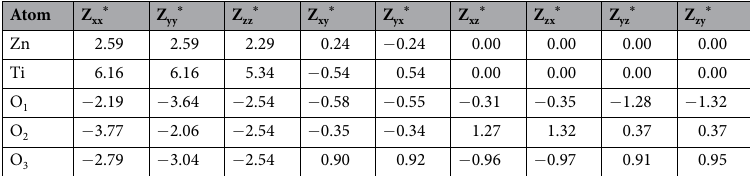
the charge populations of the s and p orbitals are 1.85 and 4.85. In addition, the calculated charge populations between nearest-neighboring (1.8652 Å) and next nearest-neighboring (2.1589 Å) Ti-O bonds are 0.56 and 0.30; the charge populations between the nearest-neighboring (2.0421 Å) and next nearest-neighboring (2.2671 Å) Zn-O bonds are only 0.29 and 0.04. The number of charges on the different bonds can reflect the covalent and ionic properties. Obviously, the chemical bonding of the Ti-O and nearest-neighboring Zn-O bonds are of mixed covalent-ionic character, however the next nearest-neighboring Zn-O bonds show ionic character. As discussed above, the hybridization of Zn-O bonds and Ti-O bonds mainly occurs in their 3d and 2p orbitals. The charge distribution of Zn-O and Ti-O bonds indicates that the empty 3d orbital in Ti 4 + (3d 0 ) more easily forms a covalent bond with O atoms than the fully occupied 3d orbital in Zn 2 + (3d 10 ). This may be the reason why the piezoelectric and nonlinear optical properties of LN-type ZnTiO 3 are superior to those of the LN-type ZnSnO 3 and LN-type ZnGeO 3 (see the results below). In the latter two compounds, it is noted that the all the cations are fully occupied 3d orbitals.